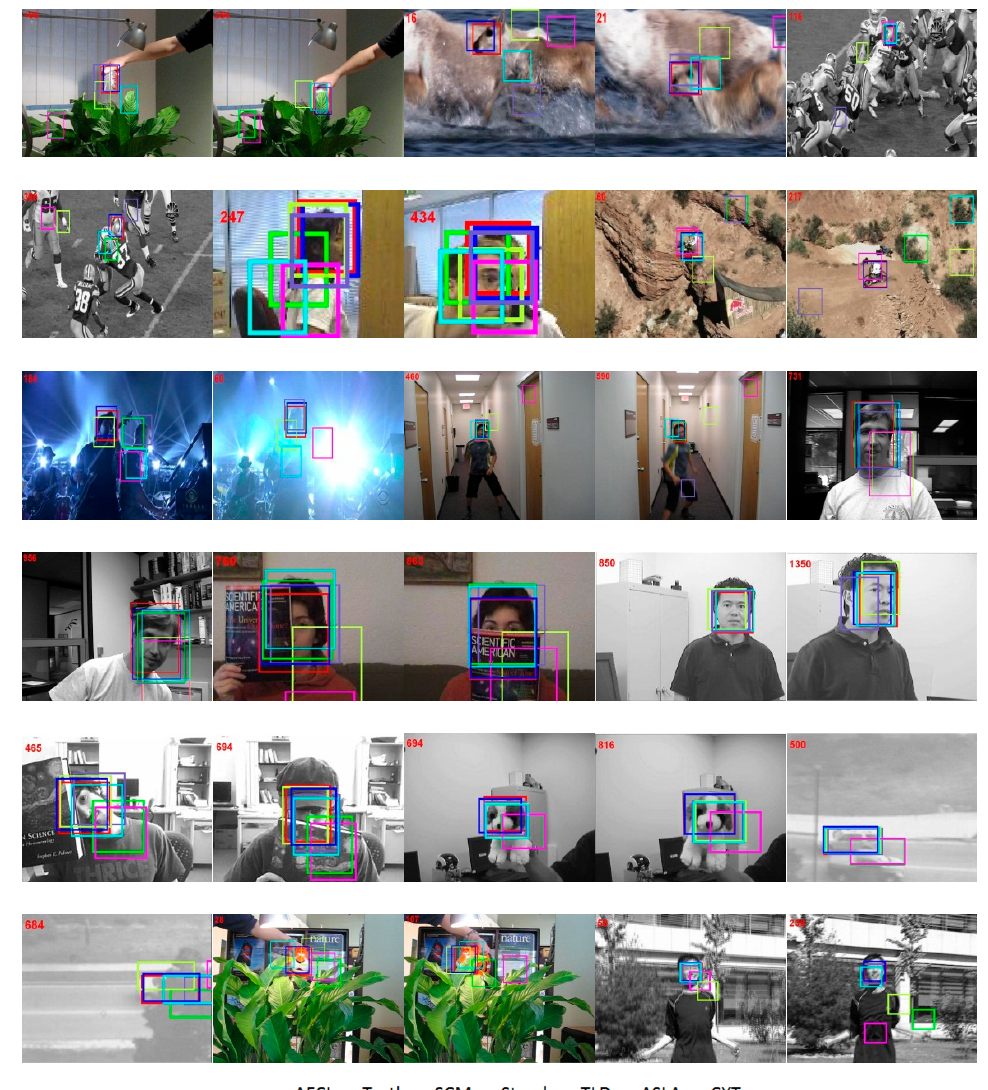
Figure 10. Tracking results of the sequences.